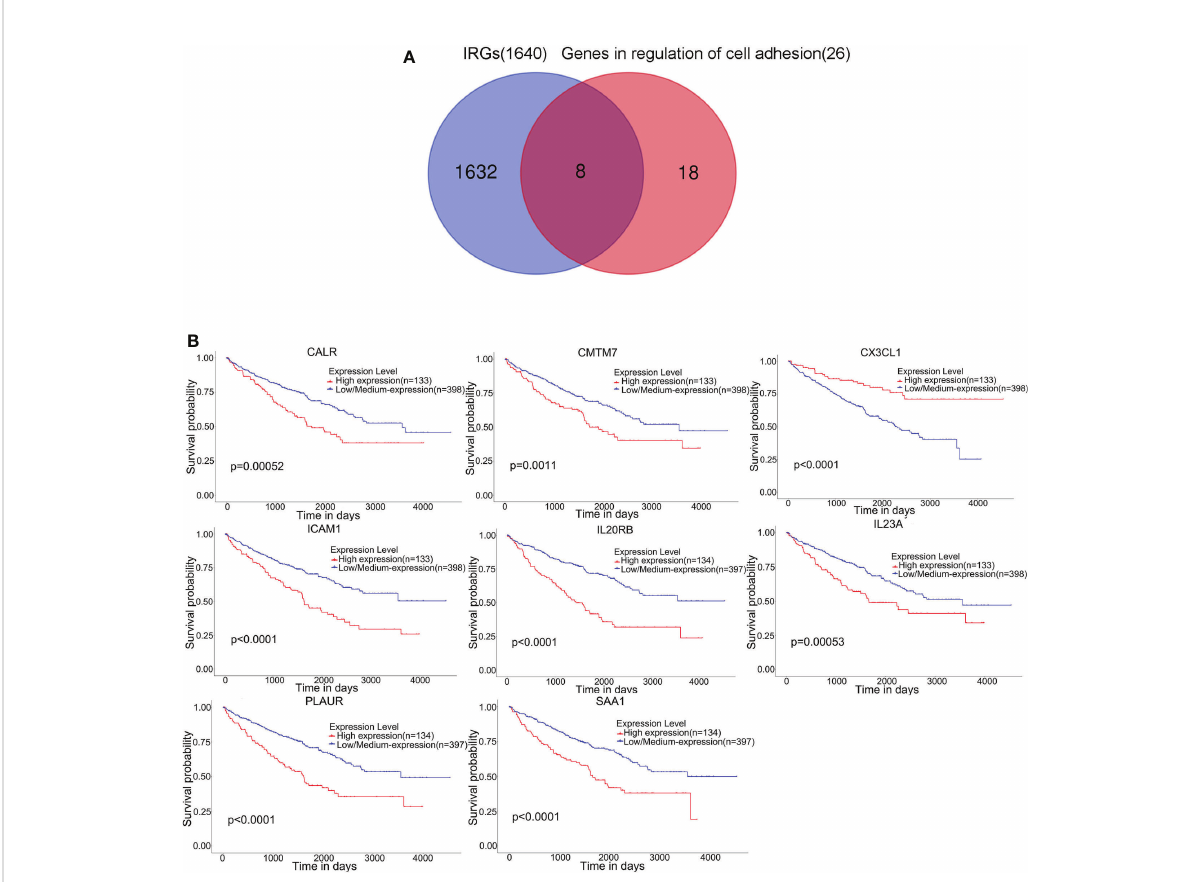
FIGURE 3 Eight hub genes were found in the regulation of cell adhesion GO term and among immune-related genes (IRGs). (A) Identi fi cation of 8 common genes between the GO biological process regulation of cell adhesion and the set of immune-related genes (IRGs). The different colored regions represent different datasets. The overlapping region indicates overlapping genes. (B) Kaplan – Meier survival analysis based on the expression of these 8 hub genes in KIRC was performed with the UALCAN